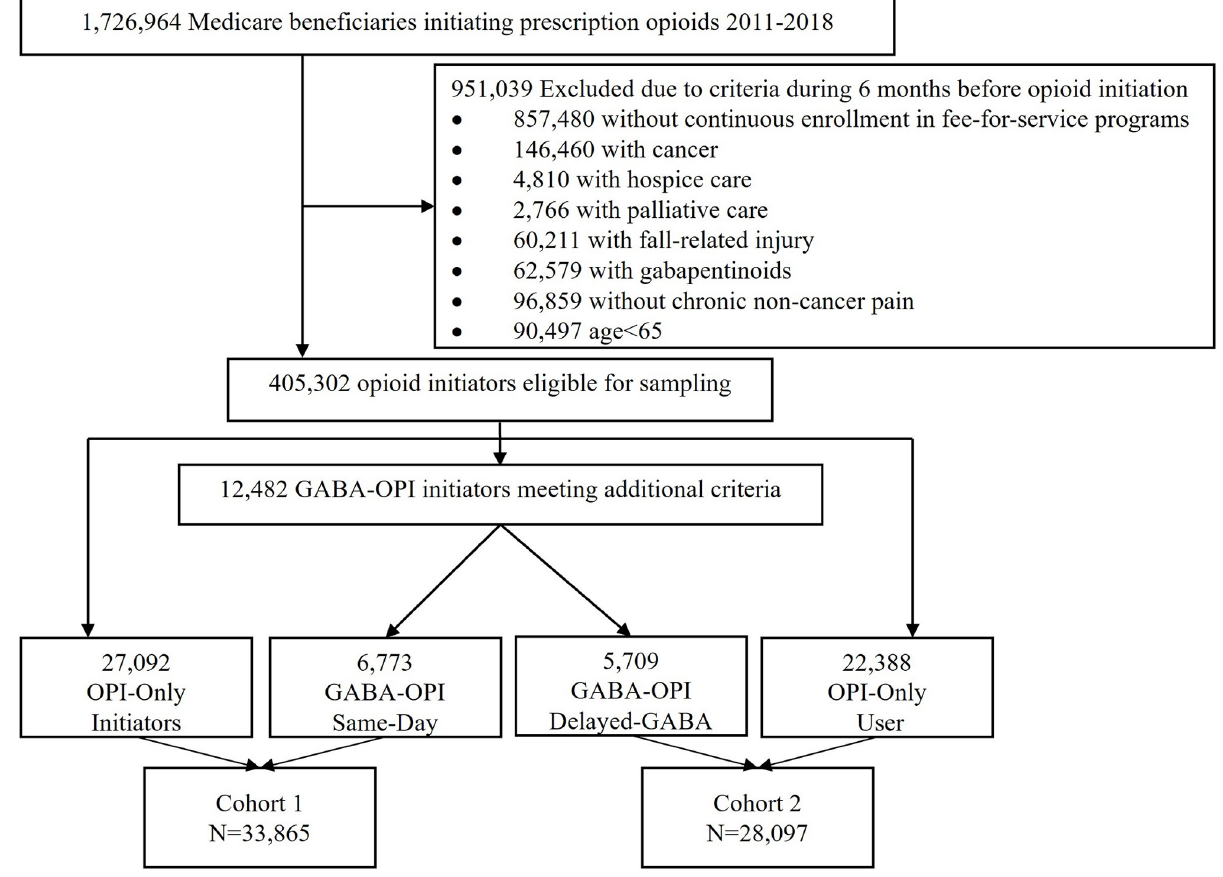
Fig 2. Flowchart of sample selection. GABA, gabapentinoid; OPI, opioid.